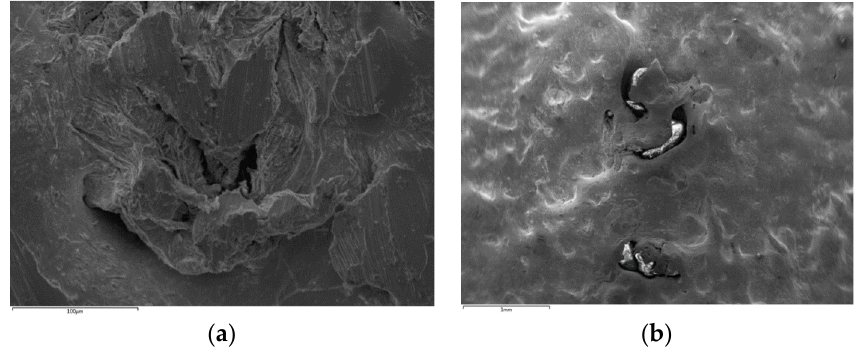
Figure 4. SEM images of ( a ) the groove defect at 350× magnification and ( b ) a sand inclusion at 26× magnification.